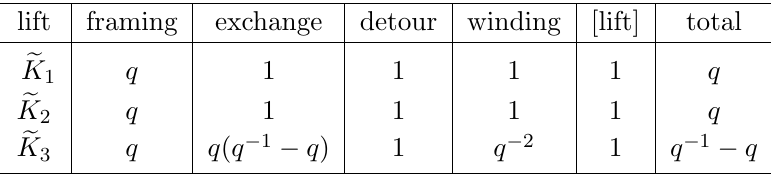
Table 2 . Summary for the three lifts of the unknot K in (cid:12)gure